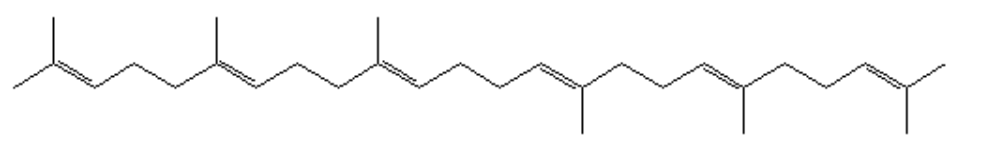
Figure 1. Chemical structure of